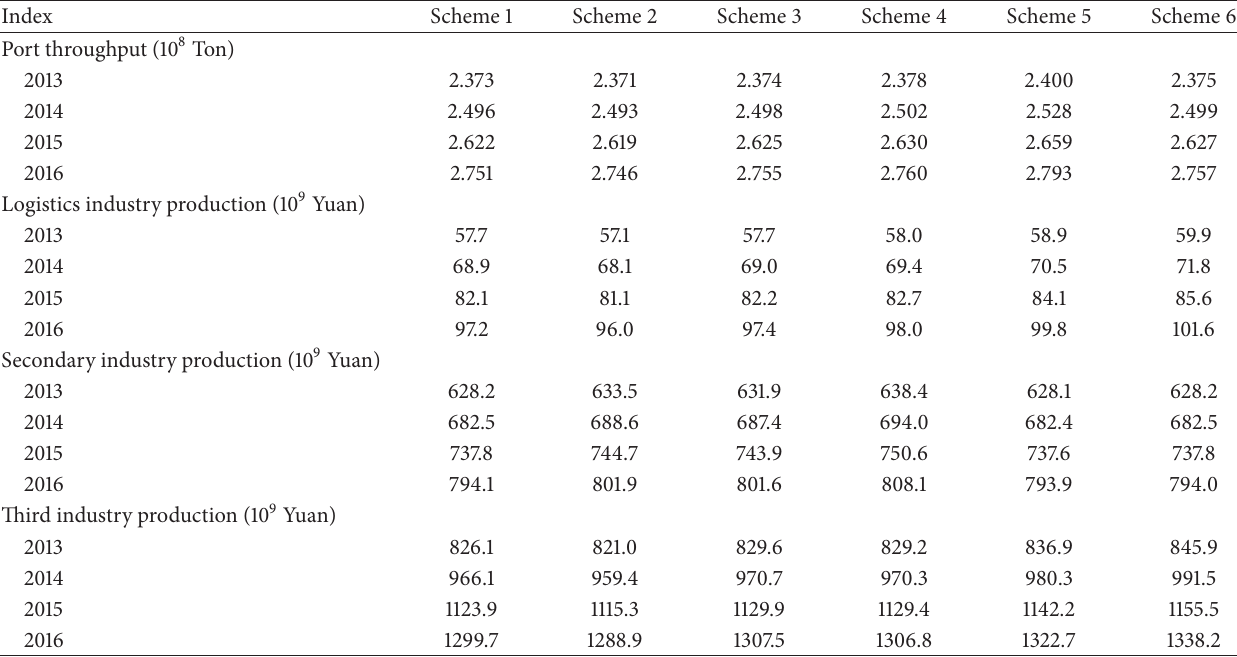
Table 3: The comparison of different simulation results.